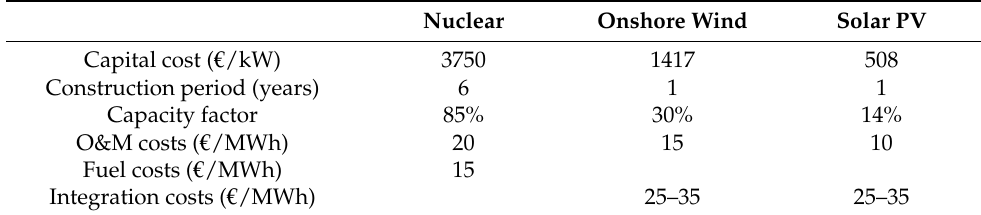
Table 10. Cost assumptions for nuclear, wind and solar